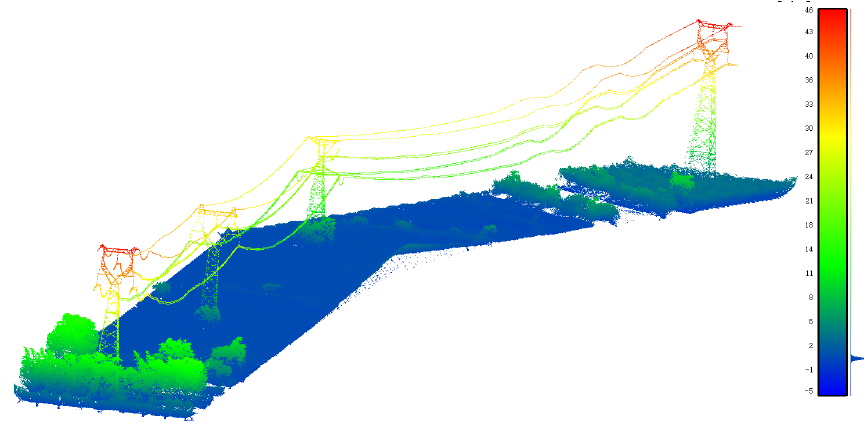
Figure 8. Normalized point cloud.